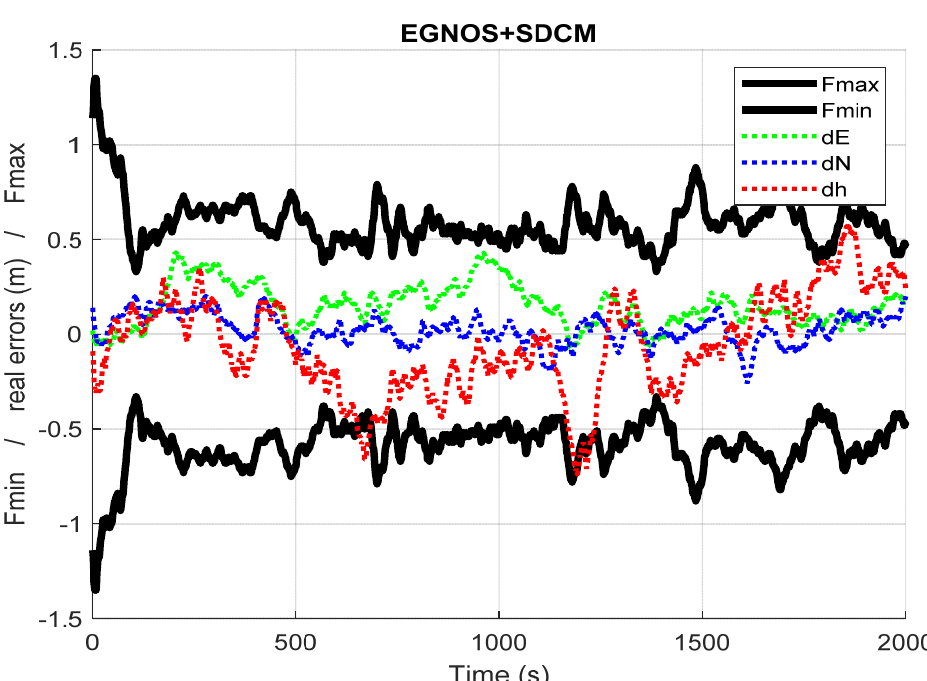
Figure 18. Confidence intervals for the calculated 3D error ( Fmin ; Fmax ) with respect to the real horizontal and vertical errors, for the dual receiver EGNOS+SDCM and C1C+C1W codes.